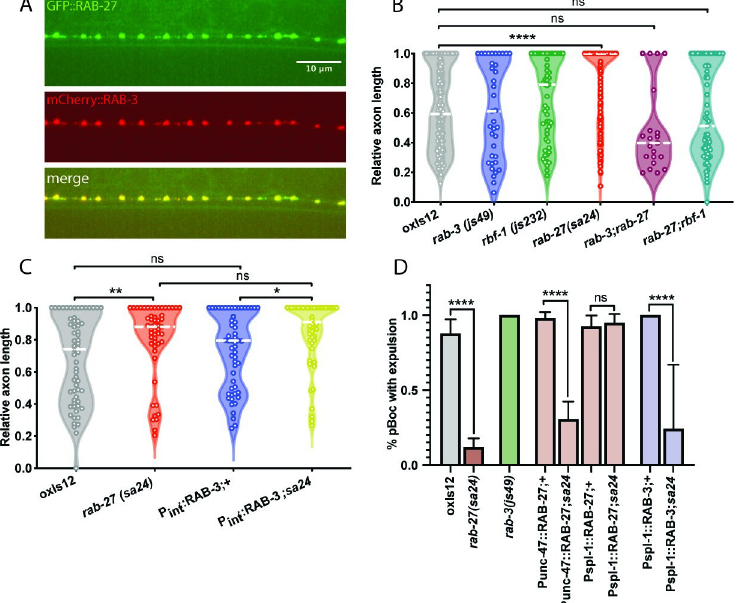
Fig 2. RAB-27’s synaptic vesicle tethering cofactors do not inhibit regeneration. (A) Colocalization of transgenic GFP::RAB-27 and mCherry::RAB-3 at synapses of DD/VD neurons. (B) Relative axon length in control ( oxIs12 ) animals, rab-3 ( js49 ), rbr-1( js232 ), rab-27 ( sa24 ), rab-3 ( js49 ); rab-7 ( sa24 ) mutants. Axons cut per genotype, L to R: 183, 37, 55, 196, 21, 69. Kolmogorov-Smirnov test was used. ns, not significant, � p < 0.05, ��� p < 0.0005. (C) Relative axon length in control animals, rab-27 ( sa24 ) mutants, and animals expressing RAB-3 cDNA under an intestine-specific promoter, in control and rab-27 mutant backgrounds. Number of axons cut per genotype, L to R: 61, 55, 53, 50. Kolmogorov-Smirnov test was used. ns, not significant, � p < 0.05, �� p < 0.005. (D) Mutants in the aex pathway display a defect in the defecation motor program, visualized by a loss of waste expulsion (Exp) following posterior body contraction (pBoc). D1 adult animals were randomly selected and observed for 5 DMP cycles, and the ratio of Exp/ pBoc was plotted. Intestinal (P spl-1 ) but not GABA neuron-specific (P unc-47 ) expression of rab-27 cDNA was sufficient to rescue DMP in rab-27 mutant worms. Expression of rab-3 cDNA in the intestine of rab-27 mutant animals did not rescue DMP defects. pBoc cycles observed, L to R: 49, 119, 30, 49, 62, 54, 56, 40, 58. ns, not significant, � p < 0.05, �� p < 0.05, ��� p < 0.0005, ���� p < 0.0001, Fisher’s Exact Test. Error bars represent